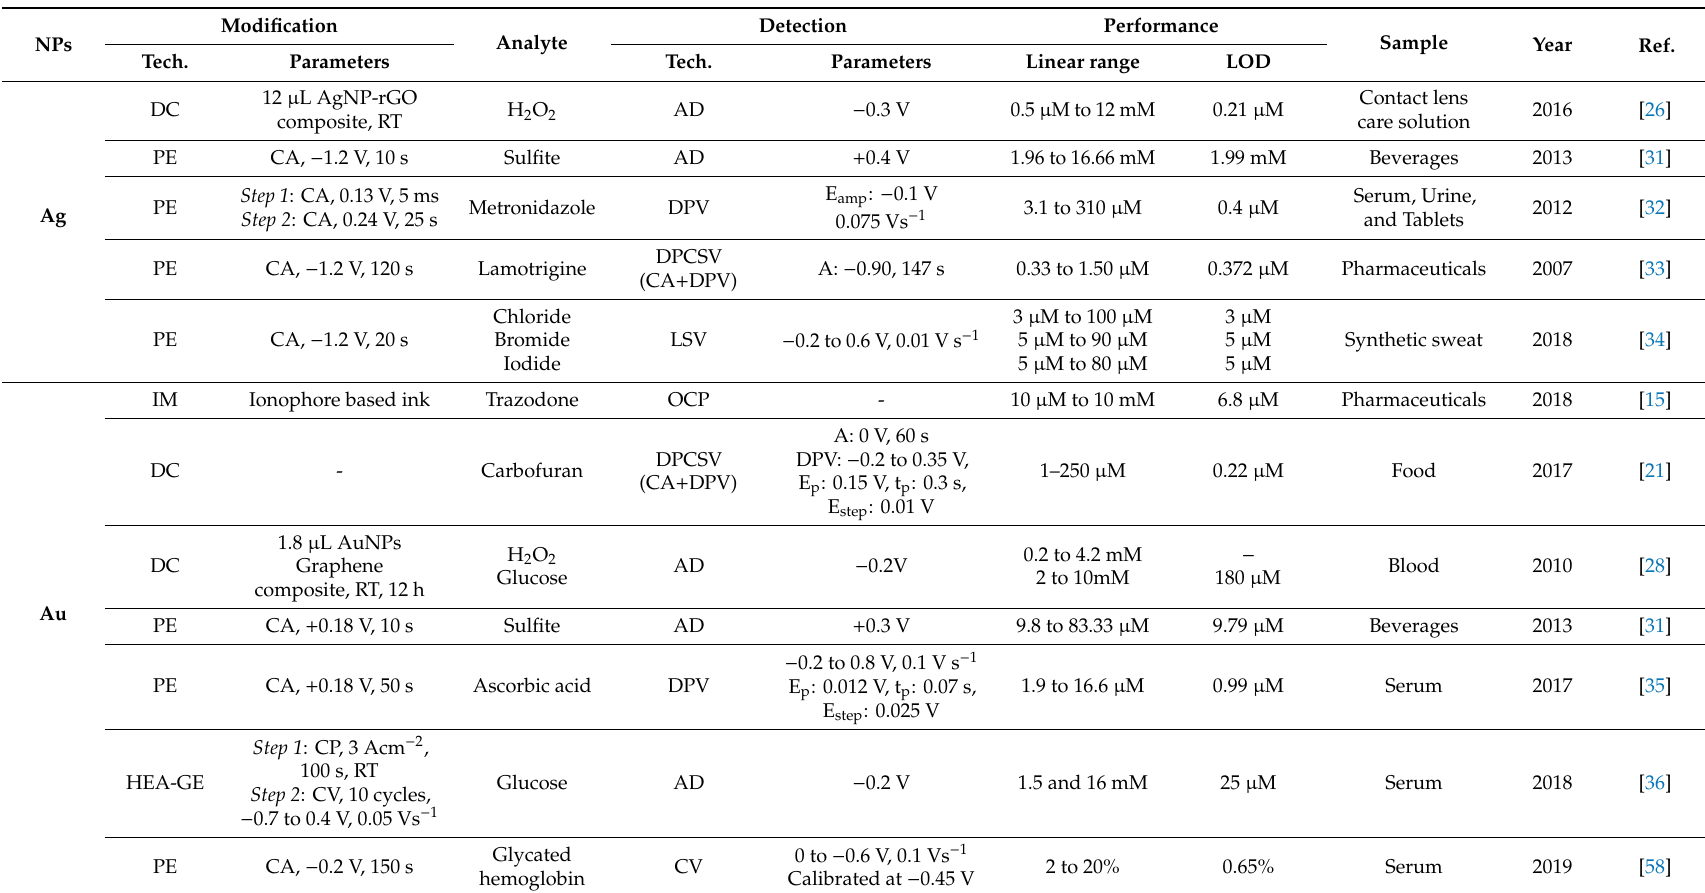
Table 1. Application of NPs with real